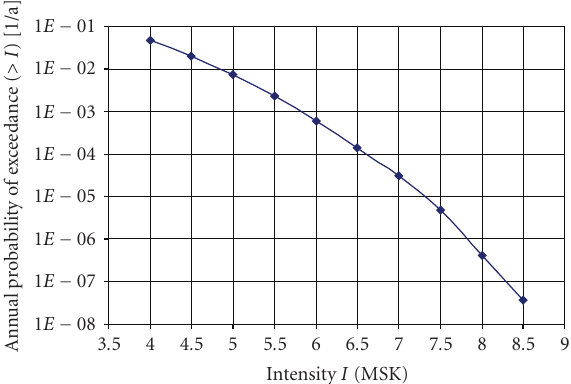
Figure 1: Hazard curve of seismic risk at plant-site.